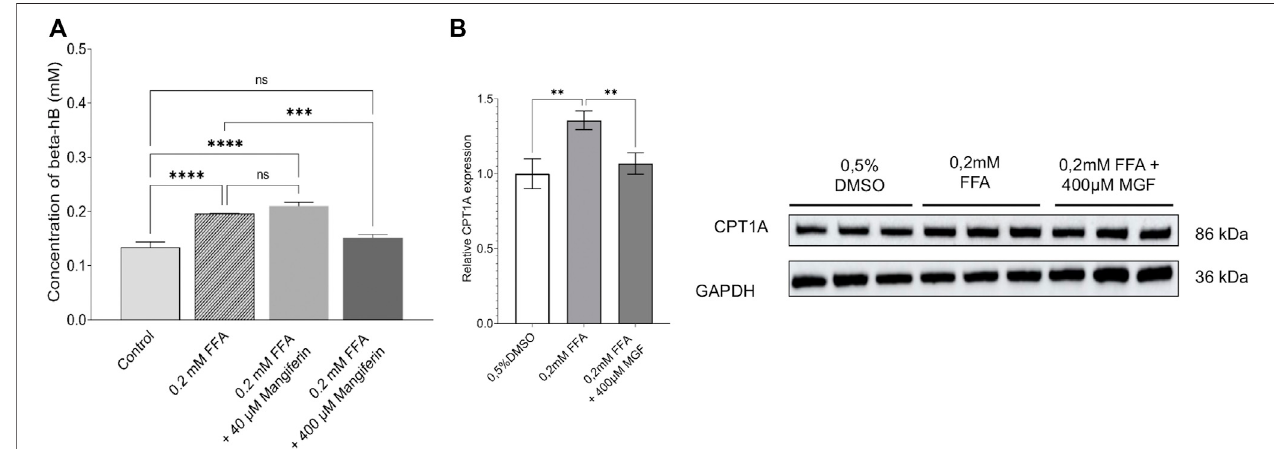
FIGURE 7 | MGF decreases free fatty acid induced fatty acid β -oxidation metabolism in human HT29 colon cancer cells. (A) Intracellular concentrations of β -hydroxybutyrateinHT29cellsinresponseto24 htreatmentwith0.2 mMfreefattyacids(FFA)increasesigni fi cantlycomparedtountreatedHT29cells.Cotreatmentwith 400 µMMGFreversesthiseffect.Dataaregivenasmean ± SD( n (cid:2) 3wells).Statisticswerecalculatedwith1-wayANOVAandTukeypost-test;*** p < 0.001;**** p < 0.0001; ns indicates not signi fi cant. (B) Representative quanti fi cation (left) of western blot analysis of relative CPT1A protein expression (right) in HT29 cells after treatment with 0.2 mM FFAor0.2 mMFFAwith 400 µM MGF. Therelative levelsofCPT1Awere quanti fi edbynormalizing toGAPDHwhichwasused asa loading control.Data are given as mean ± SD of three biological replicates. Statistics were calculated with 1-way ANOVA and Dunnett ’ s adjustments; ** p < 0.01 compared to FFA treated